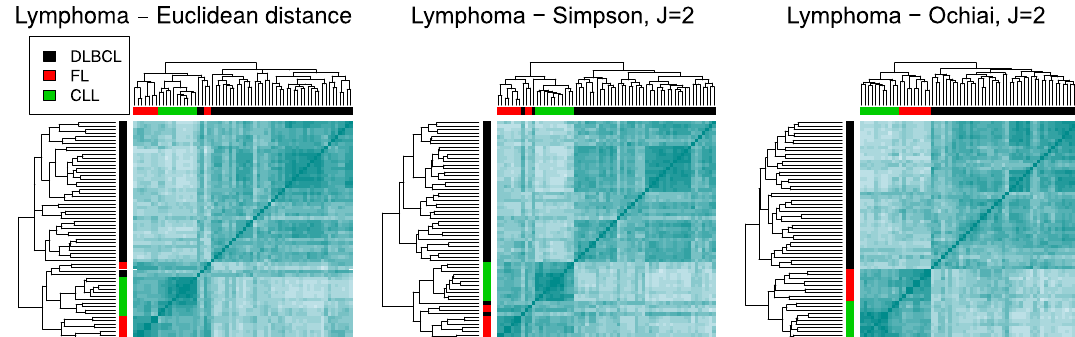
Figure 5. Clustering the lymphoma data set. Dendrograms and heatmaps for the lymphoma data set, using the Euclidean distance (left), the Simpson index (middle) and the Ochiai index (right), for J = 2 . The Euclidean distance merges 2 DLBCL and 2 FL samples with the CLL group. S identifies the structure better, misplacing 1 DLBCL in the FL group and 1 DLBCL in the CLL group. O completely restores the three classes.